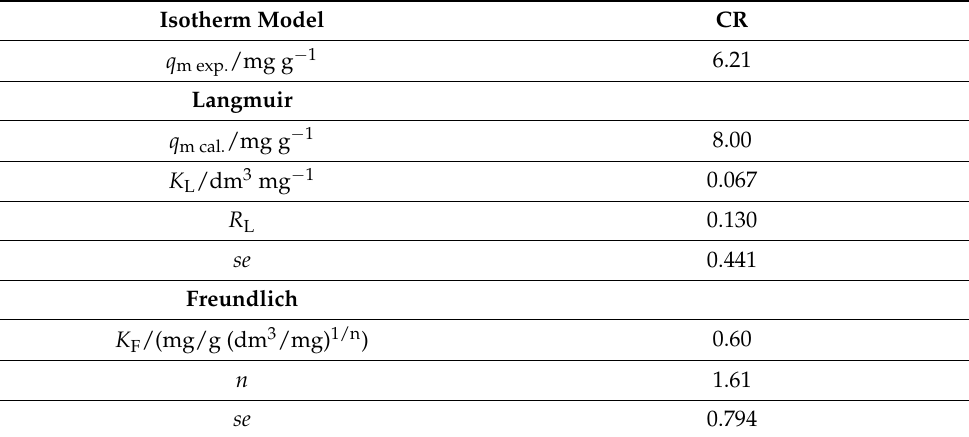
Table 2. Isotherm parameters for the removal of CR by EP at 298.15